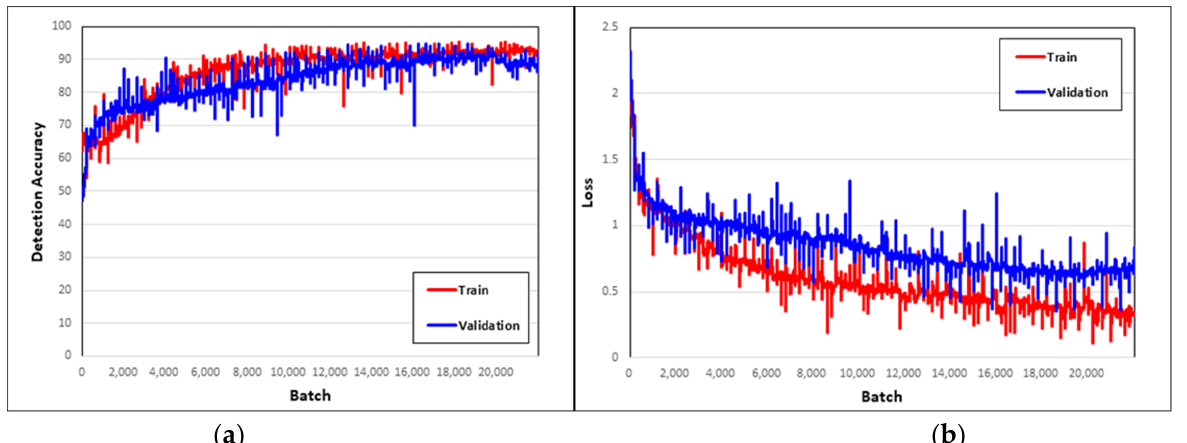
Figure 11. Loss and Accuracy of the Proposed RNN Model. ( a ) Accuracy of the proposed RNN Model ( b ) Loss of the proposed RNN Model.